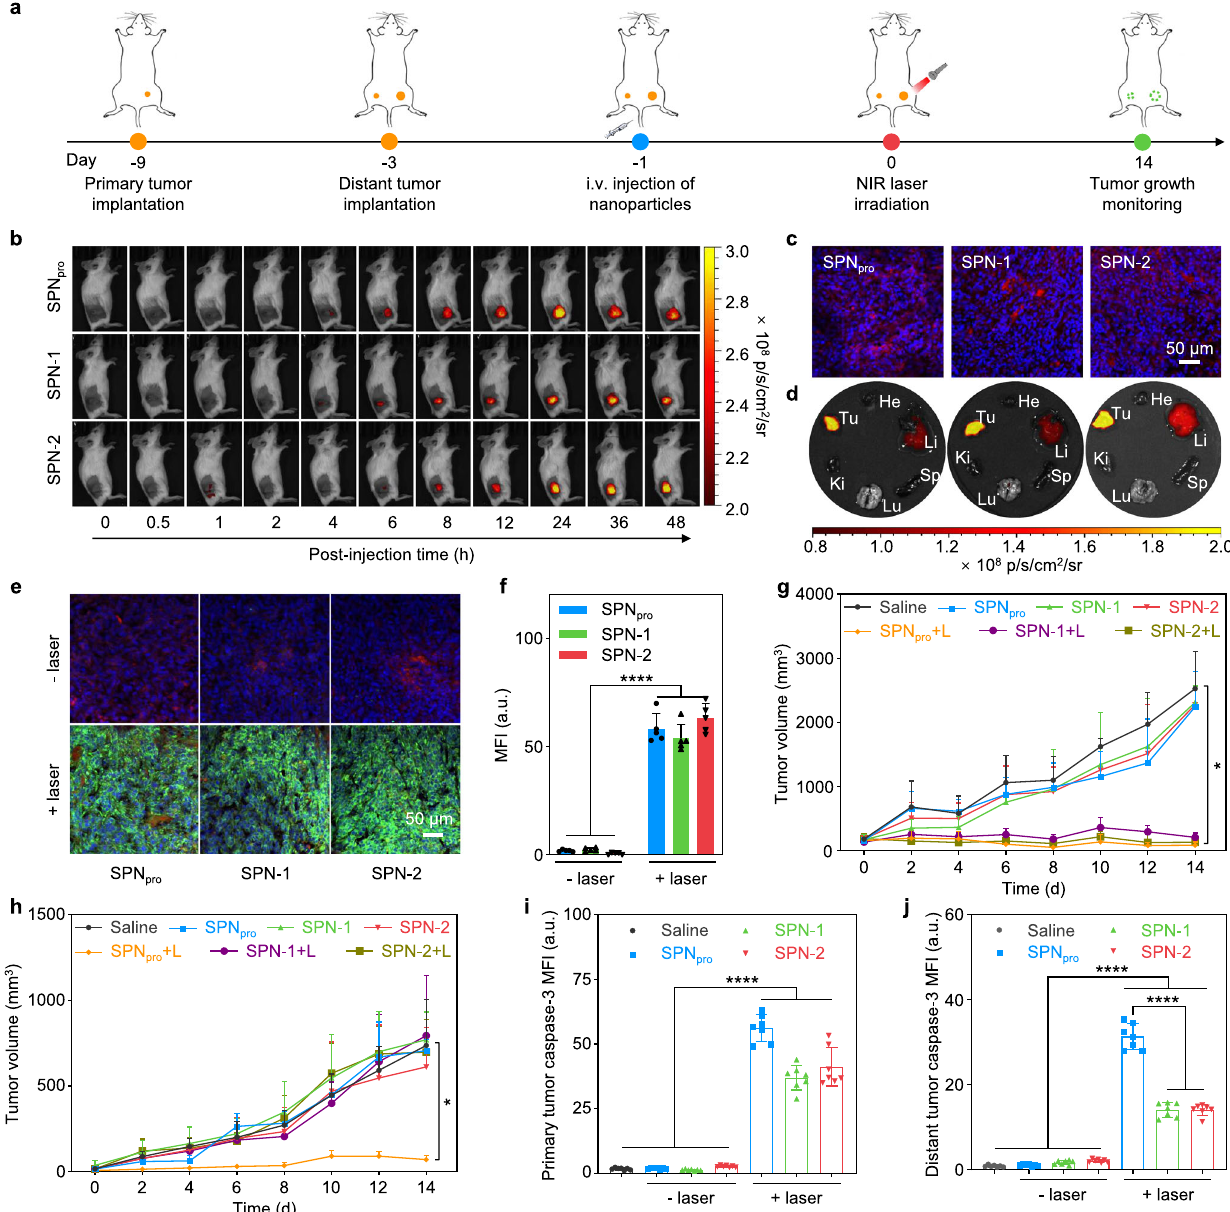
Fig. 4 In vivo NIR fl uorescence imaging and SPN pro -mediated activatable photo-immunometabolic therapy. a Schematic illustration of the schedule for tumor model implantation and SPN pro -mediated activatable photo-immunometabolic therapy. b NIR fl uorescence imaging of 4T1-tumor-bearing BALB/c mice at different timepoints after the intravenous injection of SPN pro , SPN-1, or SPN-2 (200 μ L, [PCB] = 200 μ g/mL). c Confocal fl uorescence images of primary tumors from 4T1-tumor-bearing mice after intravenous injection of SPN pro , SPN-1, or SPN-2. Blue fl uorescence showed the cell nucleus stained with DAPI, and red fl uorescence showed the signals from the PCB core. d Ex vivo NIR fl uorescence images of tumors and major organs in 4T1-tumor- bearing mice at 48 h after intravenous injection of SPN pro , SPN-1, or SPN-2. e Confocal fl uorescence images of primary tumor tissues from SPN pro -, SPN-1-, or SPN-2-injected (200 μ L, [PCB] = 200 μ g/mL) 4T1-tumor-bearing mice with or without NIR photoirradiation (0.3 W/cm 2 at 808 nm) for 6 min. Blue fl uorescence showed the cell nucleus stained with DAPI, red fl uorescence showed the signals from the PCB core, and green fl uorescence showed the signals from SOSG. f Quantitative analysis of SOSG MFI in primary tumor tissues of mice after different treatments ( n = 5). p < 0.0001. Growth curves of primary tumors ( g ) and distant tumors ( h ) in 4T1-tumor-bearing mice after different treatments ( n = 5). Saline-treatment versus SPN pro -treatment group: p = 0.0043 for primary tumors ( g ); p = 0.0192 for distant tumors ( h ). Quanti fi cation of caspase-3 expression in primary ( i ) and distant ( j ) tumor tissues of 4T1-tumor-bearing mice ( n = 7). p < 0.0001. Statistical signi fi cance in f , i , and j was calculated via one-way ANOVA with a Tukey post-hoc test. Statistical signi fi cance in g and h was calculated via two-tailed Student ’ s t -test. * p < 0.032, ** p < 0.0021, *** p < 0.0002, and **** p < 0.0001. The mean values and SD are presented. The experiments in c and e were repeated independently three times with similar